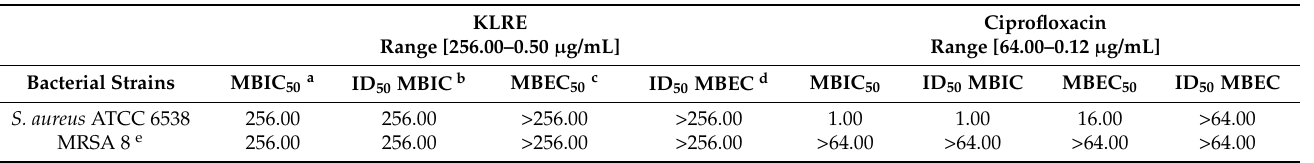
Figure 4. Minimal biofilm eradication concentration (MBEC) of ciprofloxacin and K. lappacea root extract (KLRE) on S. aureus ATCC 6538 and MRSA 8. S. aureus ATCC 6538 and MRSA 8 were exposed to different concentrations of ciprofloxacin ( A , C ), ranging from 0.12 to 64.00 µ g/mL or KLRE ( B , D ), ranging from 0.50 to 256.00 µ g/mL, for 24 h. In the x-axis are reported the biofilm eradication and metabolic activity of untreated (positive control) and ciprofloxacin/KLRE treated bacterial strains. The values are expressed as a percentage of positive control. The bars represent the means ± SD of three independent experiments (SD = standard deviation). Statistically significant differences, determined by two-way analysis of variance ANOVA, are indicated: * p ≤ 0.05, § p ≤ 0.0001 versus positive control. Table 2. Effect of Krameria lappacea root extract (KLRE) and ciprofloxacin on biofilm formation (MBIC 50 ), biofilm eradication (MBEC 50 ) and metabolic activity (ID 50 ) of S. aureus strains.